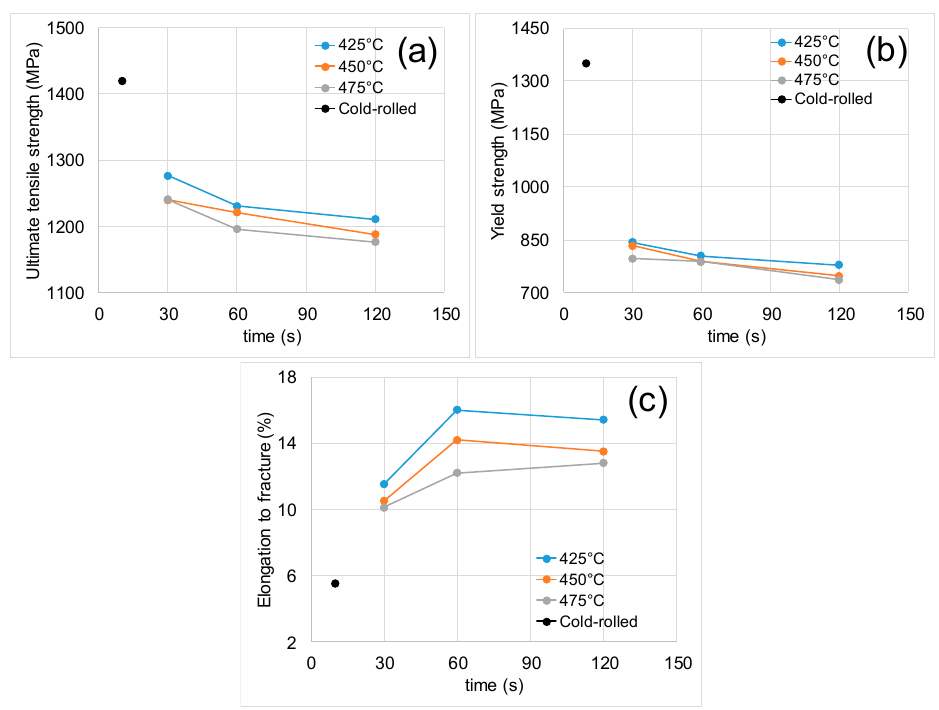
Figure 13. Effect of time and temperature of isothermal bainitic treatment on: ( a ) ultimate tensile strength, ( b ) yield strength, and ( c ) elongation to fracture.